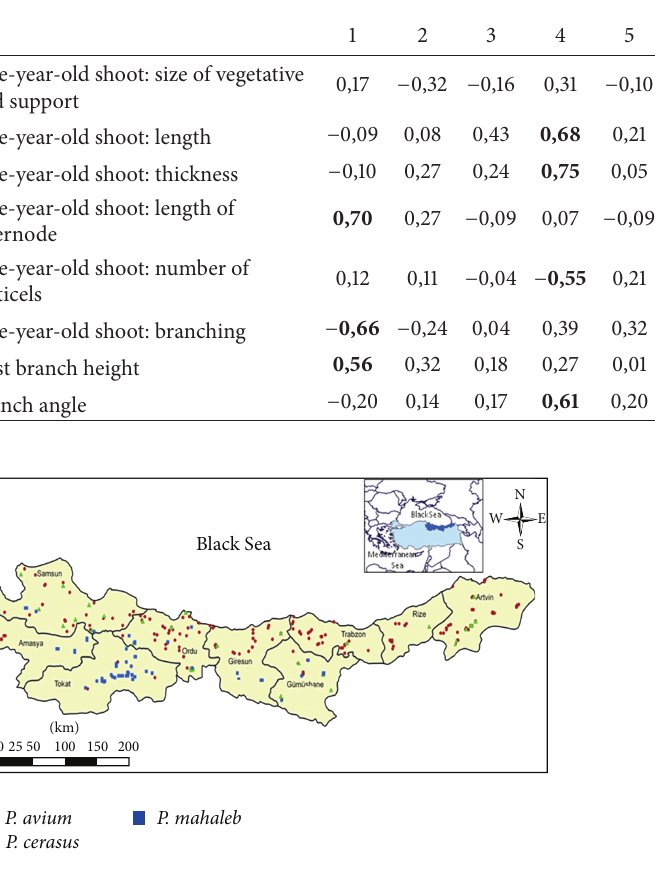
Figure 1: Map of the distribution for genotypes in Central and East Black Sea Regions in Turkey.